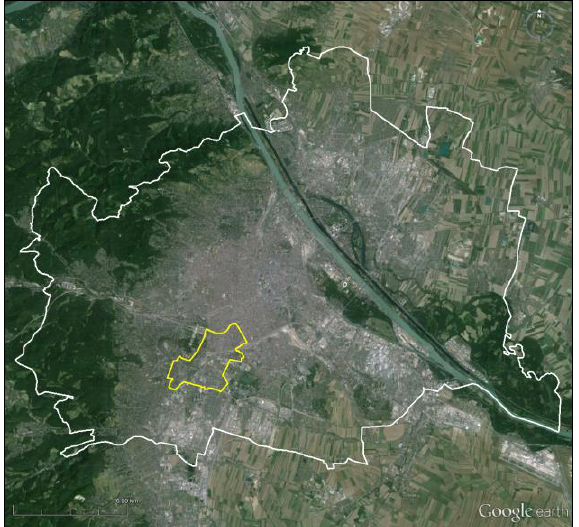
Figure 1. Boundaries of Vienna (in white) and extents of the district of Meidling (in yellow). Image source: Google